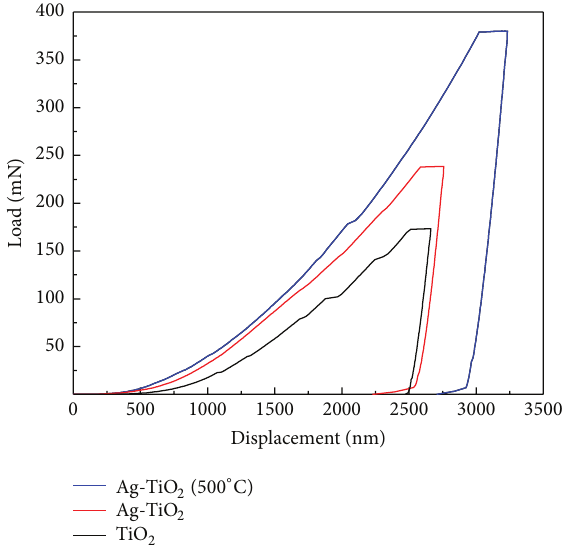
Ag-TiO 2 ( 500 ∘ C) Ag-TiO 2 Figure 2: Characteristic load versus nanoindentation depth for TiO 2 , Ag-TiO 2 , and Ag-TiO 2 (500 ∘ C) nanotube.